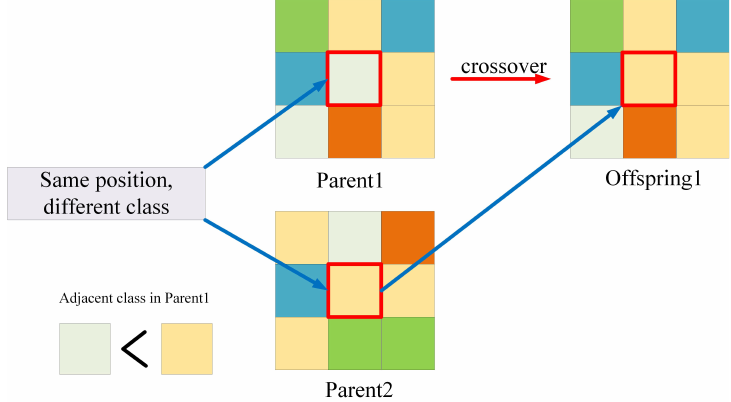
Figure 5. Schematic illustration of the procedure for crossover: replacing the center cell in Parent1 if the new center cell type in Parent2 results in neighbors of the same class that outnumbers those in Parent1.